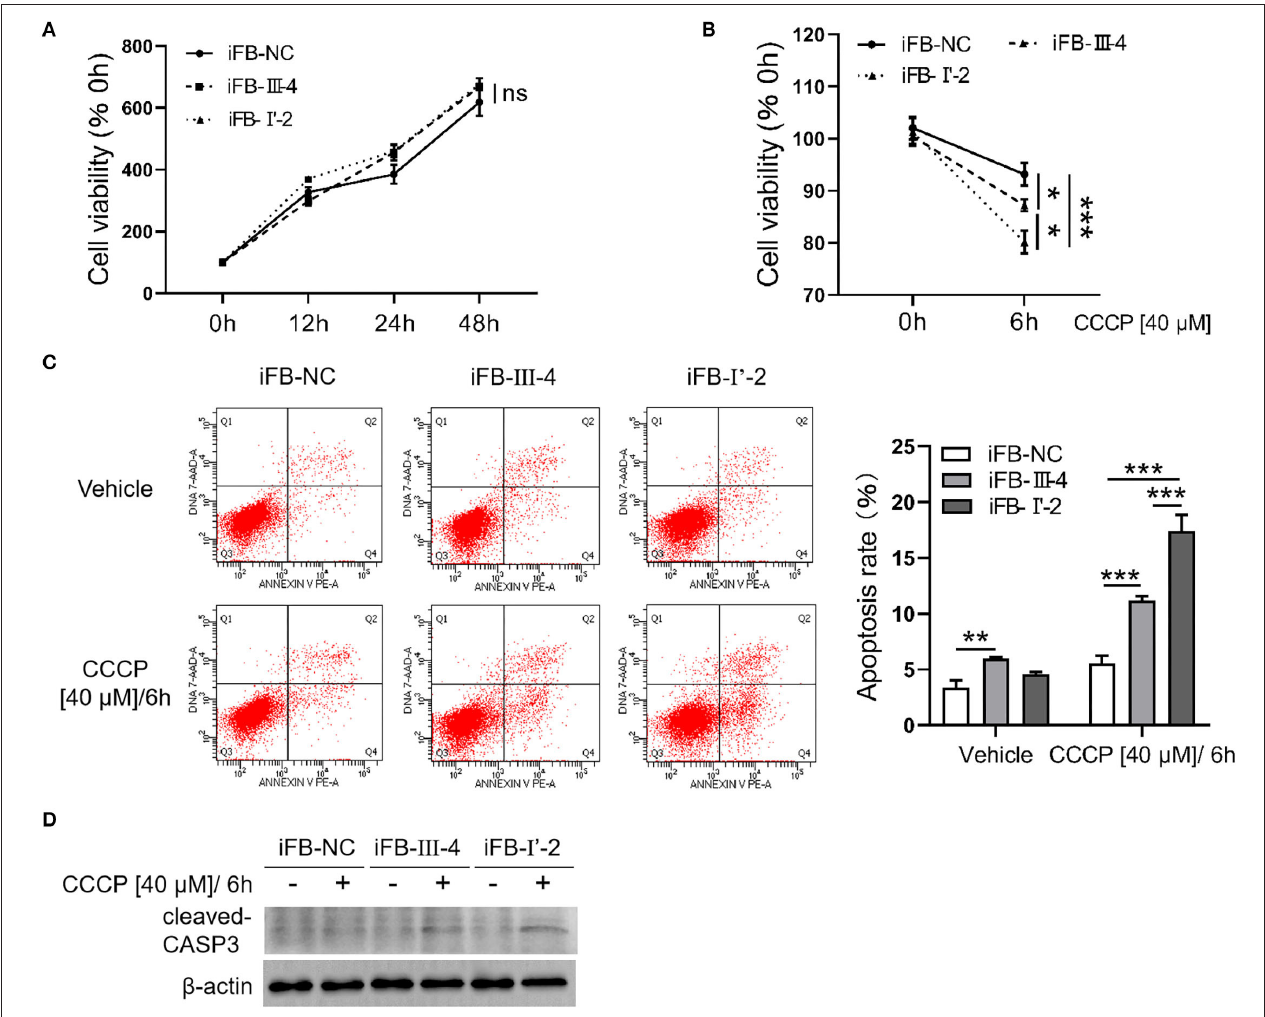
FIGURE 5 | Fibroblast cells with more mtDNA variants were more sensitive to stimuli. (A) Fibroblast cells were cultured for 48h. The cell viability was detected in 0, 12, 24, and 48h, respectively, using CCK8. (B) Cells were treated with CCCP [40 µ M] for 6h and cell viability was measured before and after treatment. * p ≤ 0.05, *** p ≤ 0.001. (C) CCCP [40 µ M/6h] treatment was performed in fibroblast cells and apoptosis level was detected using flow cytometry. ** p ≤ 0.01, *** p ≤ 0.001. (D) Fibroblasts cells were collected after CCCP [40 µ M/6h] treatment and cleaved-CASP3 was detected using western